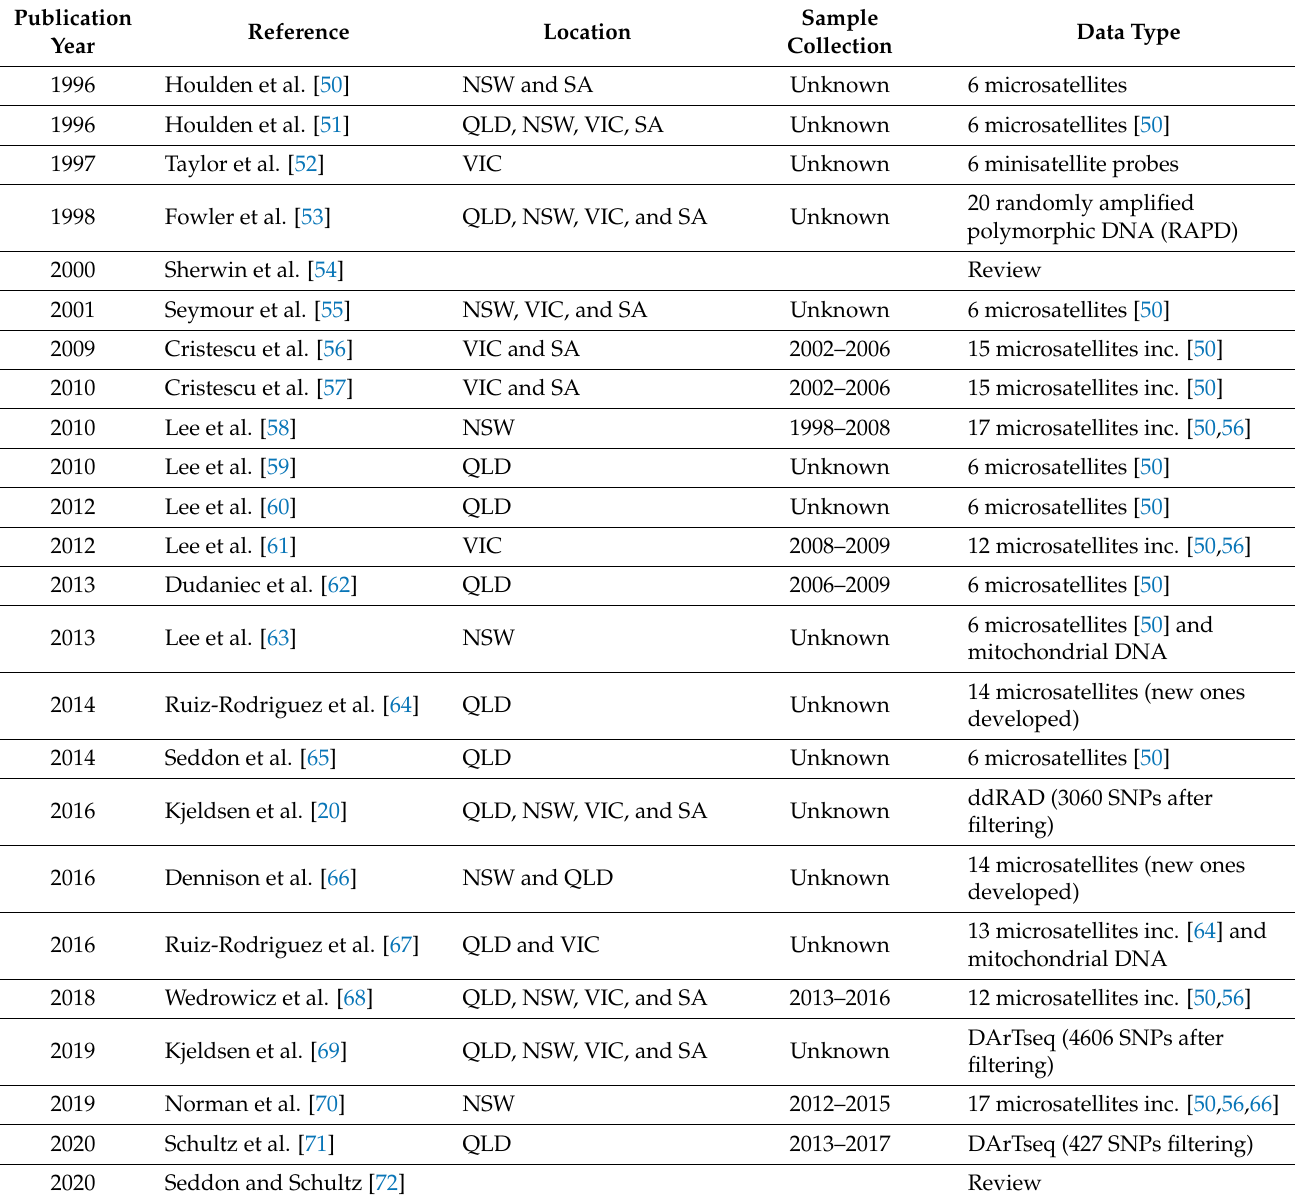
Table 1. Population genetic papers studies published between 1996 and August 2020, including location of sampling, sample collection year, and data type used in the